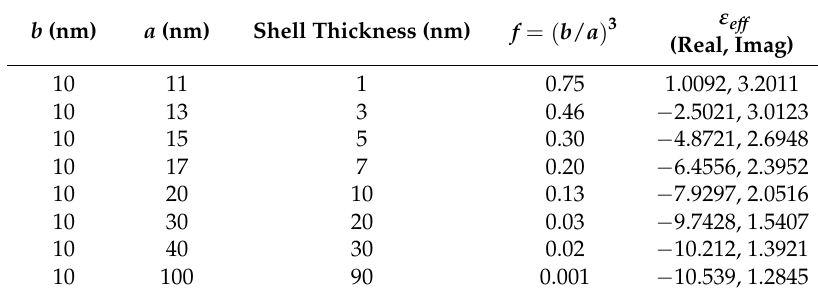
Table 1. The effective permittivity of an Fe 3 O 4 @Au core-shell for variations of shell thickness. Imag: imaginary.